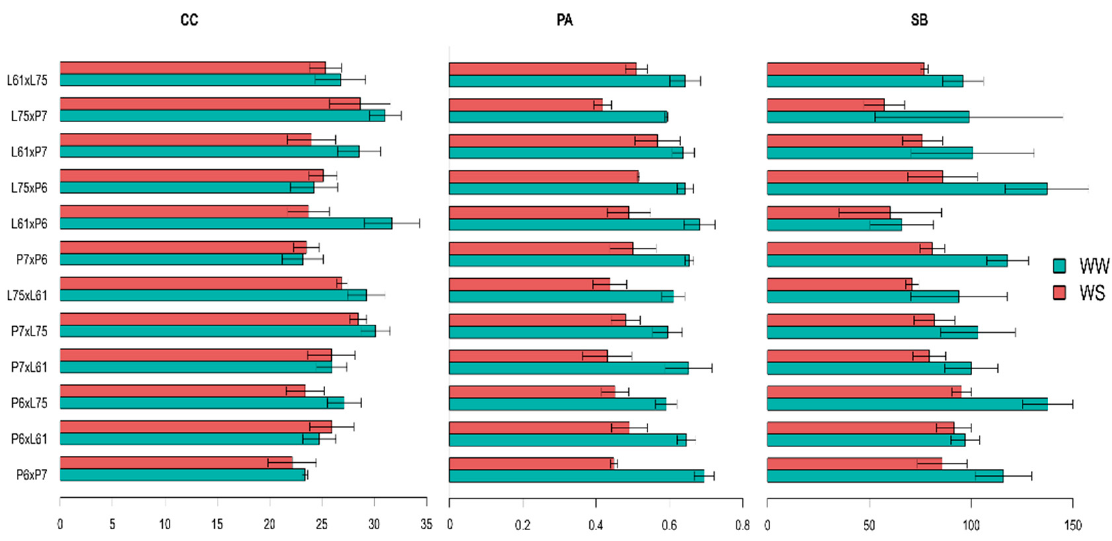
Figure 5. Estimates of the means of morphological traits of popcorn hybrids evaluated under water stress (WS) and well-watered (WW) conditions. WS: water stress; WW: well-watered; SB: shoot biomass (g); PA: whole plant area (m 2 ); CC: chlorophyll concentration (Dualex index). Regarding SCA for the CC trait, the highest estimates were observed in L75 × P6 (1.46) in WW and L61 × P6 (1.11) in WS (Figure 4). For this same trait, hybrids L61 × P6, L61 × P7